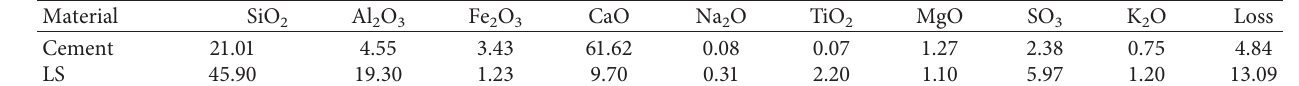
Table 2: Chemical composition of cement and LS (%).